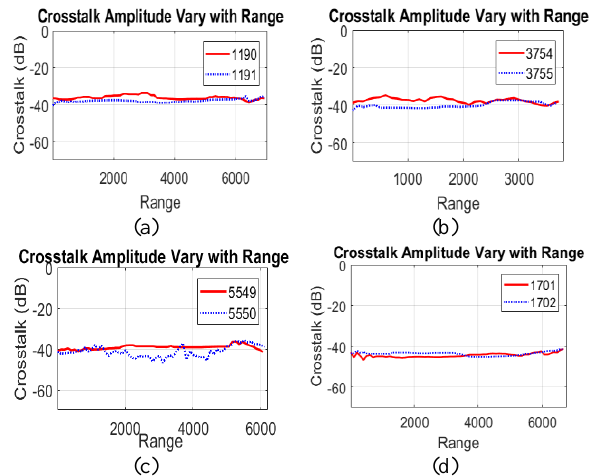
Figure 2. The residual Crosstalk Amplitude error in the image.